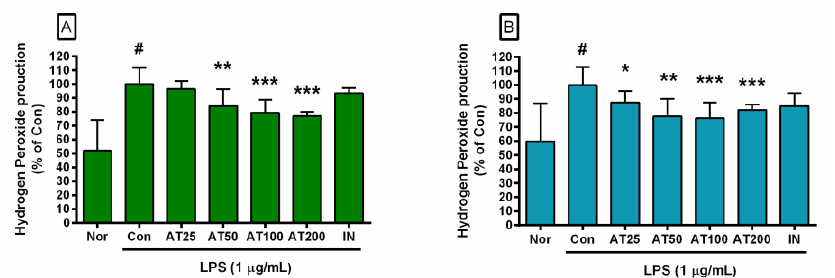
Figure 2. Effects of AT on hydrogen peroxide production after incubation with RAW 264.7 macrophages for 24 h ( A ) and 48 h ( B ). Values are presented as mean ± SD. Nor, the group treated with cell culture media alone; Con, the group treated with lipopolysaccharide (LPS, 1 µ g/mL) alone. AT25 means 25 µ g/mL of AT, AT50 means 50 µ g/mL of AT, AT100 means 100 µ g/mL of AT, and AT200 means 200 µ g/mL of AT. IN, indomethacin at 0.5 µ M. #, p < 0.05 vs. Nor; *, p < 0.05 vs. Con; **, p < 0.01 vs. Con; ***, p < 0.001 vs.